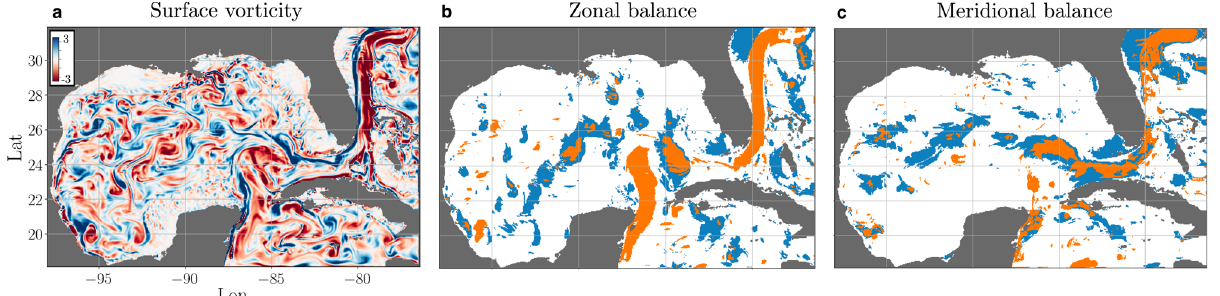
Fig. 4 Circulation in the Gulf of Mexico. The fl ow is visualized with surface vorticity in units of s − 1 ( a ) and identi fi ed balance models are shown for zonal ( b ) and meridional ( c ) dynamics. Orange regions are identi fi ed with the geostrophic balance, while the blue regions are time-varying in response to the pressure gradient and regions in white are associated with the linearized rotating Navier – Stokes